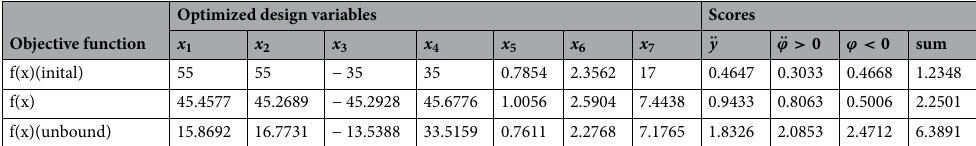
Optimized design variables Scores x Objective function